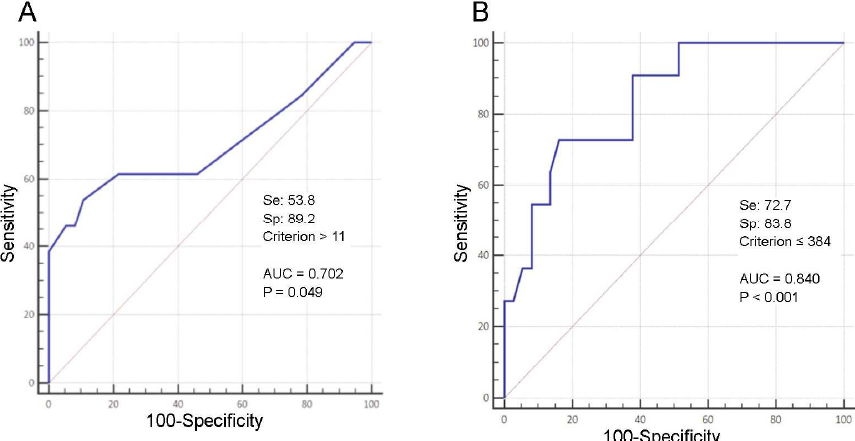
Figure 2. Predictive ROC curves for Able (1) and Frail (0) subjects. ( A ) TUG duration; ( B ) 6 MWT distance. AUC = Area Under the Curve; Criterion = Youden’s Index; SE = sensitivity; SP = Specificity; 6 MWT = six-minute walking test; TUG = Timed Up and Go test.